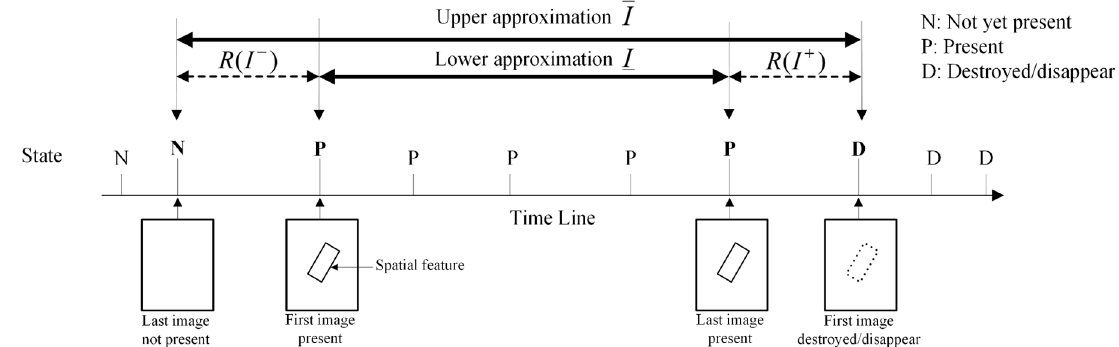
Figure 6. Rough time interval of a military feature’s lifetime in a time series of aerial photos.